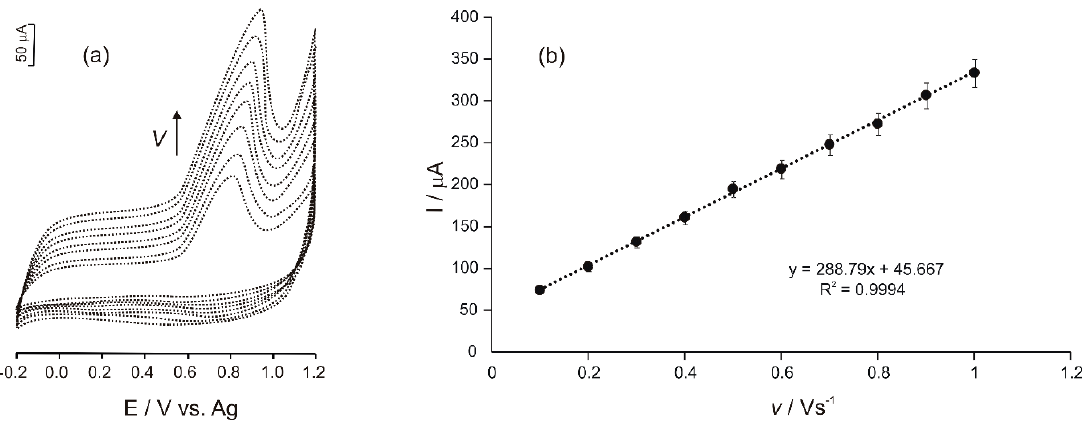
Figure 4. ( a ) CVs of Ty/PtNP/GPH/Chit-CSPE immersed into a Tyr solution (10 − 4 M) prepared in phosphate-buffered saline (PBS) (0.1 M, pH = 7) at different scan rates ranging between 0.1–1.0 V · s − 1 and ( b ) variation of anodic peak current versus scan rate. Measurements were performed in triplicate (Relative standard deviation, RSD = 3.54%).